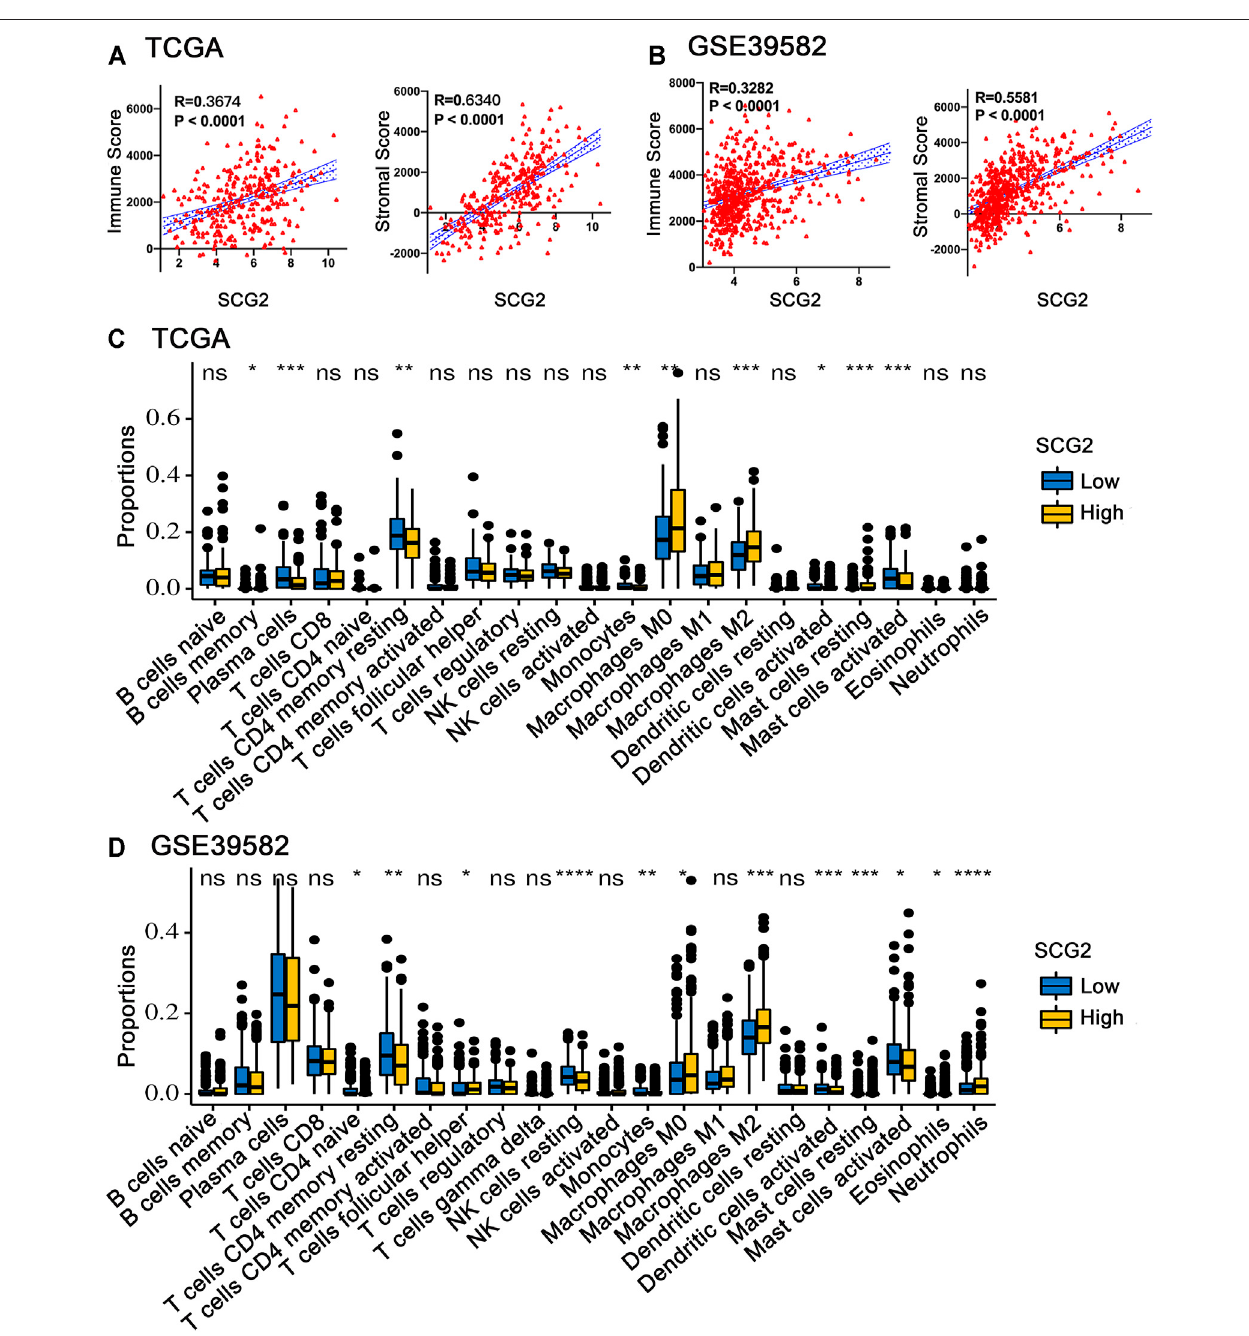
FIGURE 5 | Correlation between SCG2 expression and TIICs. (A) The correlation analysis between SCG2 expression and immune score, stromal score in TCGA cohort. (B) The correlation analysis between SCG2 expression and immune score, stromal score in GSE39582 cohort. (C,D) Twenty-two kinds of tumor-in fi ltrating immune cells are plotted according to the SCG2 expression level in TCGA and GSE39582 cohort. (A,B) Examined by Spearman ’ s correlation analysis; (C,D) Examined by Mann-Whitney U test; * p < 0.05, ** p < 0.01, *** p < 0.001, **** p < 0.0001.